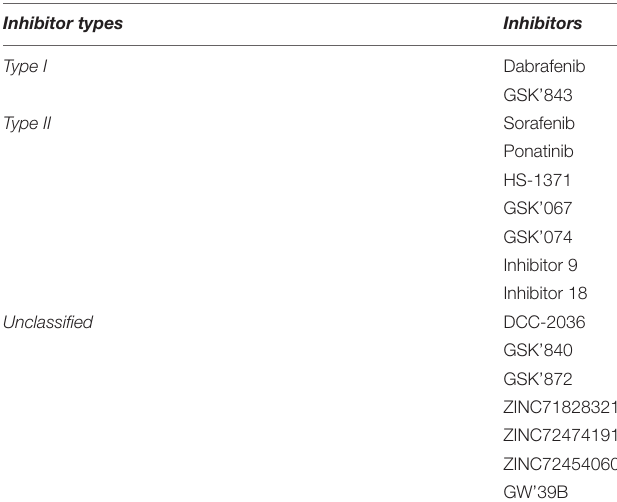
TABLE 1 | The RIPK3 inhibitors (Martens et al.,